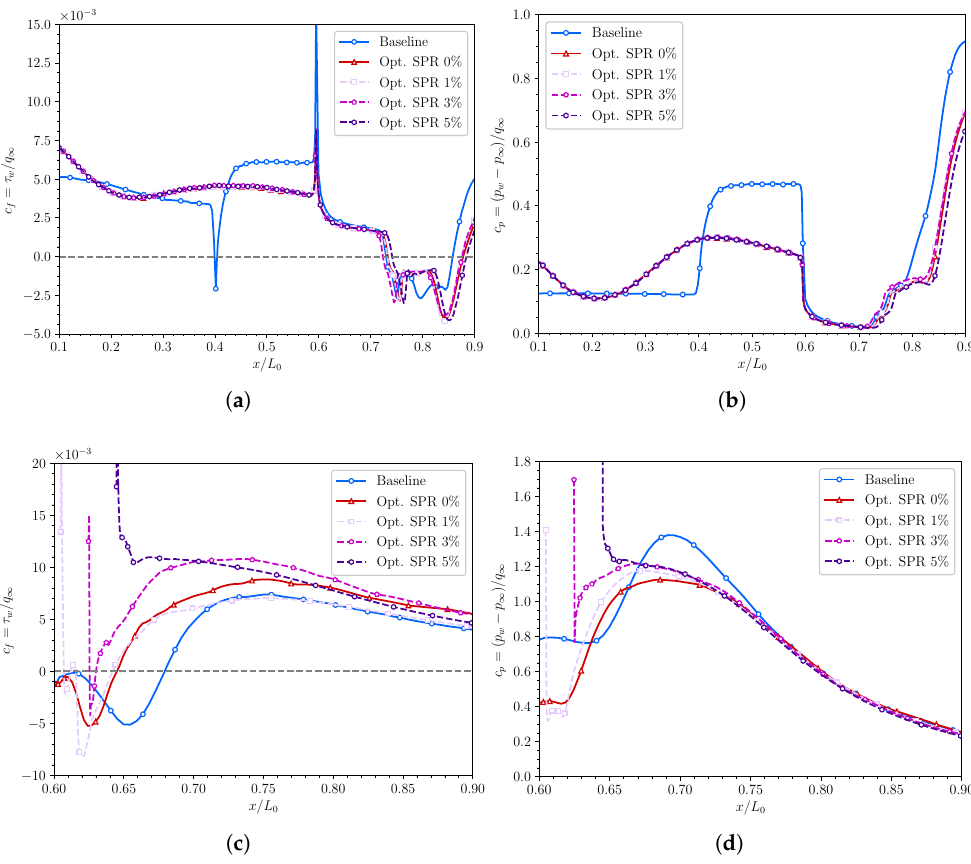
Figure 18. Friction and pressure coefficient trends along the bottom and the top surfaces for the baseline, the optimal SPR design and three SPR-optimal derived backward cowl lip configurations. ( a ) Friction coefficient (bottom surface); ( b ) Pressure coefficient (bottom surface); ( c ) Friction coefficient (top surface); ( d ) Pressure coefficient (top